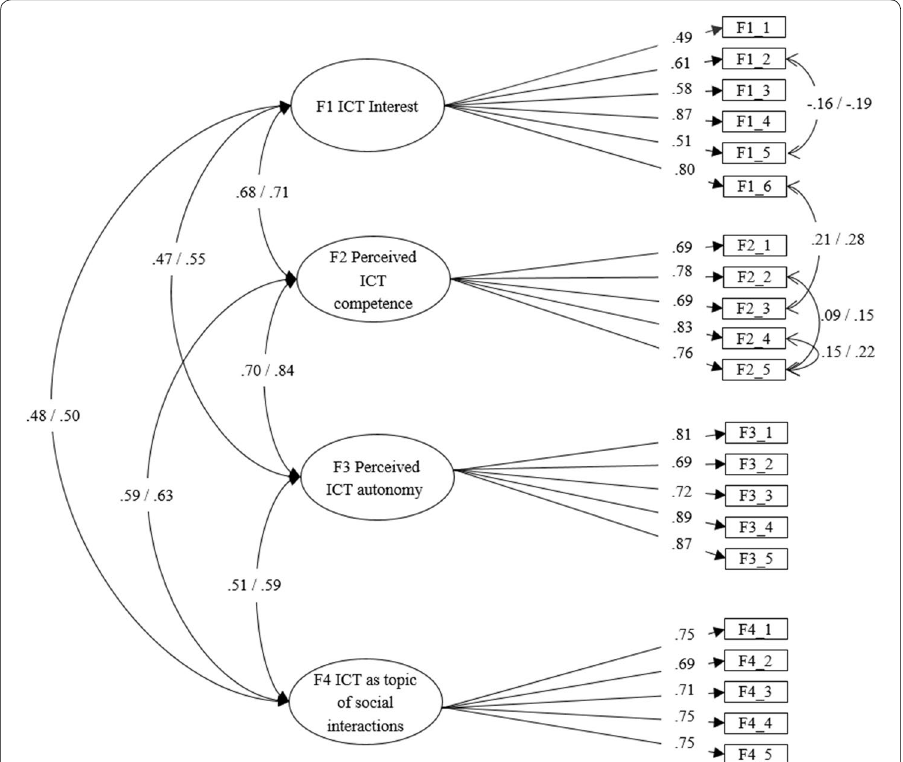
Fig. 1 Measurement model for ICT Engagement. The coefficients in front of the forward slash refer to values for the Swiss sample, whereas the values after the forward slash refer to the results for the German sample. The presented values are based on the scalar SEM with fixed factor loadings and thresholds (Model fit χ 2 14,925.18; df 413; p < .001; CFI 0.933; RMSEA = = = =